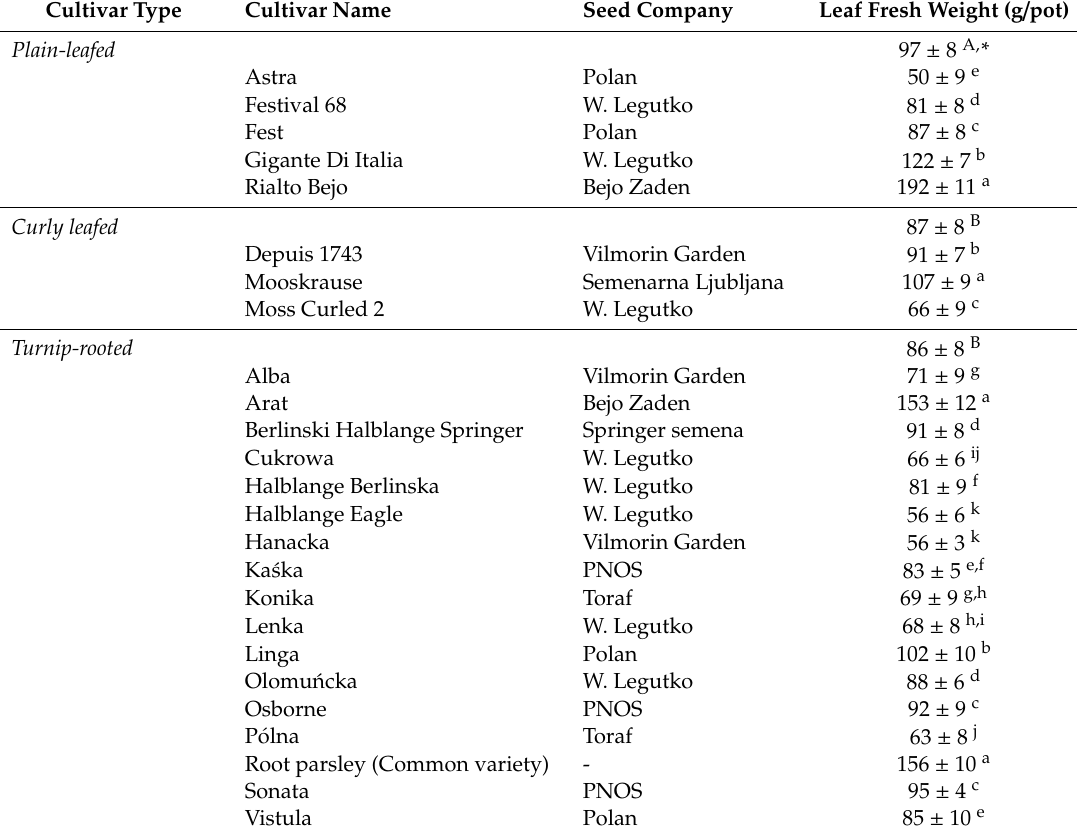
Table 1. List of genotypes and cultivars used in the present experiment (type of cultivar and Seed Company) and fresh weight of the leaves per pot (mean ±